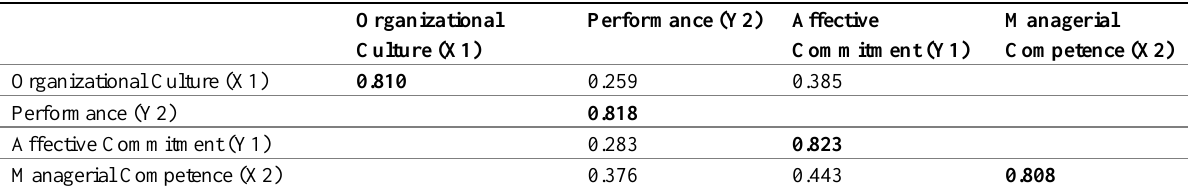
Table 15: Fornell-Larcker